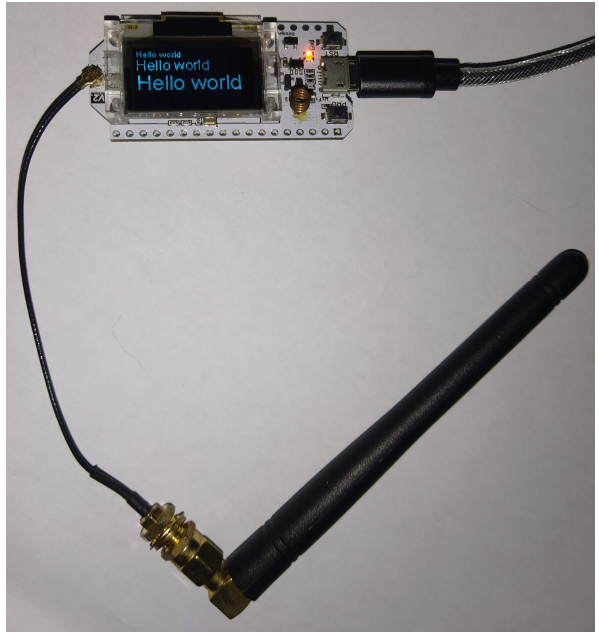
Figure 3. One of the nodes of the network, complete with its